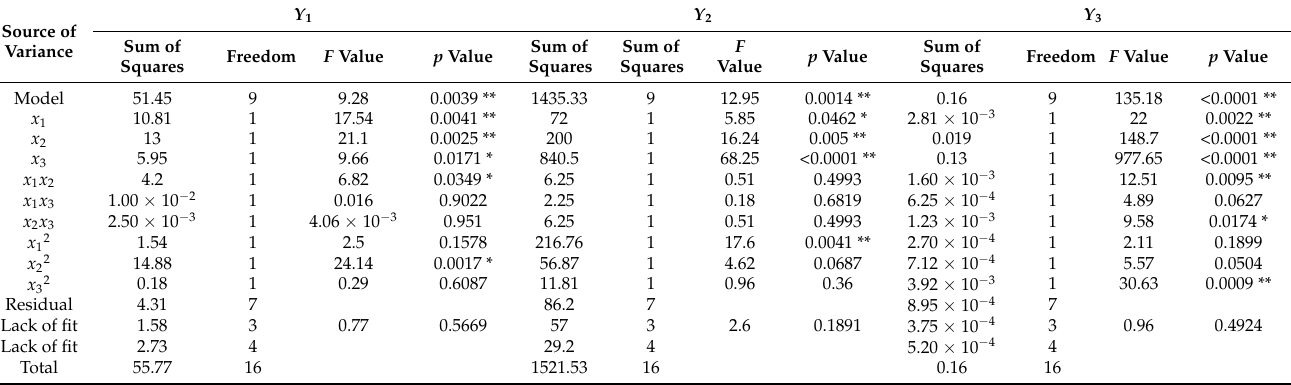
Table 5. Variance analysis of regression